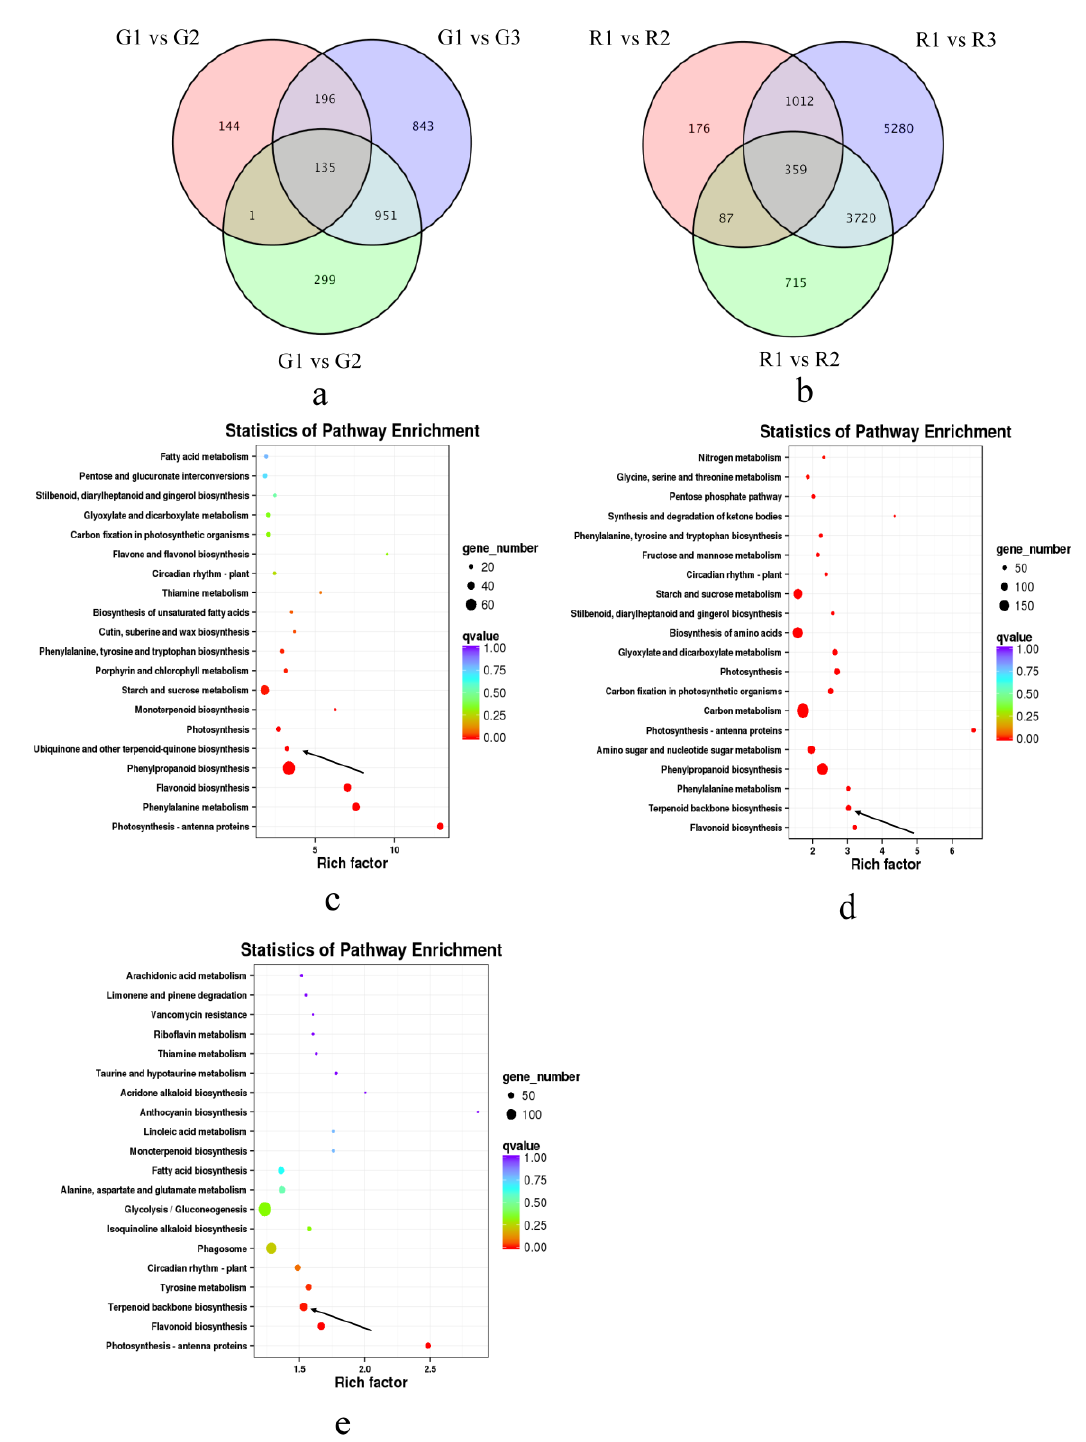
Figure 3. Analysis of differentially expressed genes at different developmental stages of green and red prickly ash. ( a ) Venn diagram of differentially expressed genes at three developmental stages of green prickly ash. ( b ) Venn diagram of differentially expressed genes at three developmental stages of red prickly ash. ( c ) KEGG enrichment analysis of differentially expressed genes at two developmental stages of green prickly ash. ( d ) KEGG enrichment analysis of differentially expressed genes at two developmental stages of red prickly ash. ( e ) KEGG enrichment analysis of differentially expressed genes at the mature stage of green and red prickly